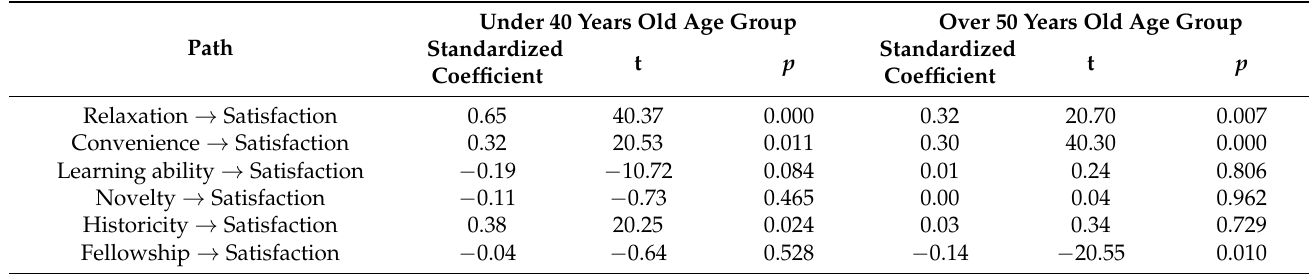
Table 9. Multiple group path analysis result (under 40 years vs. over 50